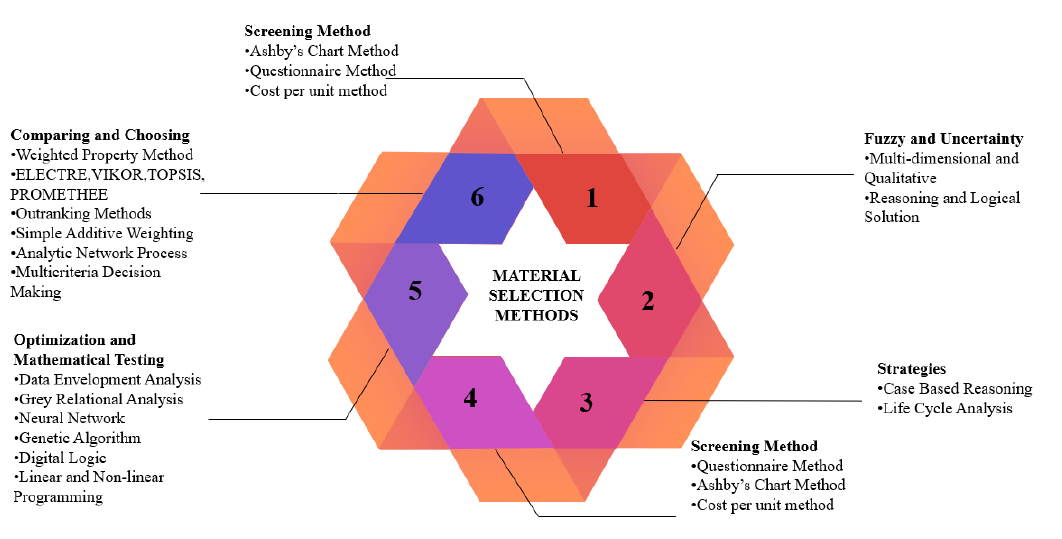
Figure 6. An assessment of material selection methods [32].